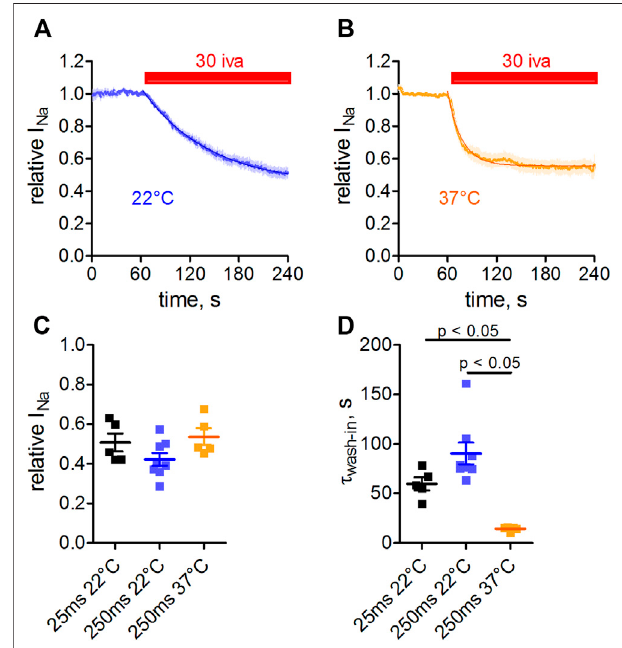
FIGURE6| Temperature-and use-dependence ofhNa v 1.5 inhibition by ivabradine. tsA-201 cells expressing human Na v 1.5 channels were held at a holding potential of − 100 mV and sodium currents were elicited by depolarizing voltage steps to − 10 mV for 250 ms every second. Normalized maximal Na v 1.5 current amplitude in the absence ( fi rst 60 s) and presence of 30 µM ivabradine (3 min application, as indicated) at a temperature of either 22 ° C (A) or 37 ° C (B) . (C) Na v 1.5 current inhibition at different depolarization times and temperatures. Values for depolarization times of 25 and 250 ms are plotted in the 1 st and 2 nd column, respectively (values for 25 ms depolarization are replotted from Figure 5 ). Values for temperatures of 22 and 37 ° C with depolarization for 250 ms are plotted in the 2nd and 3rd columns, respectively. (D) As in C , but for the wash-in time constants. Data are expressed as mean ± SEM ( n = 5, 8,